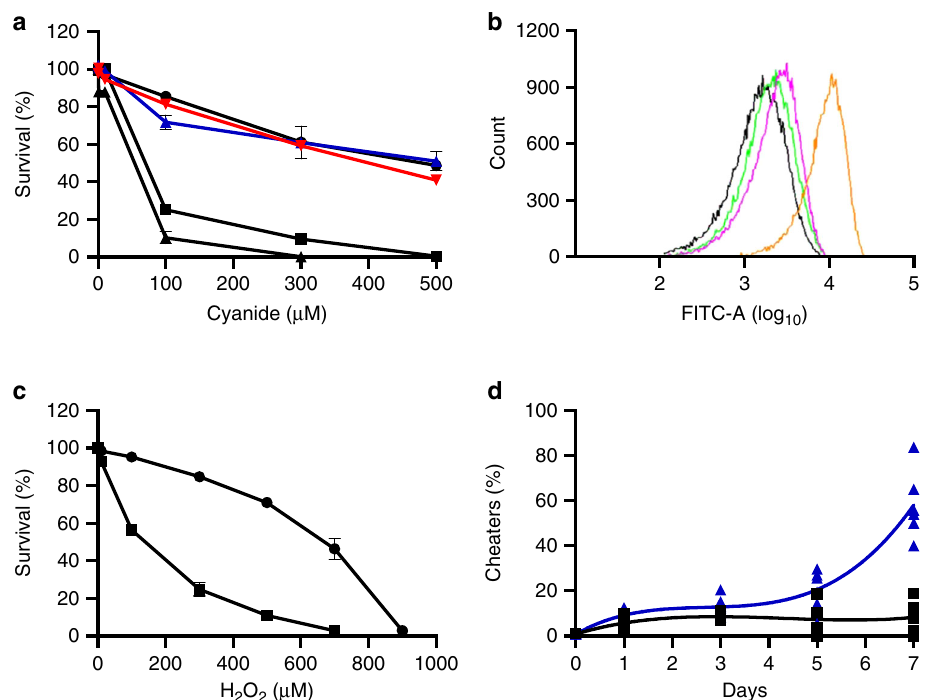
Fig. 1 Wild-type PAO1 is more resistant to cyanide and ROS intoxication than a LasR mutant. a Survival of WT PAO1, LasR-mutant, RhdA-mutant, PA4133- mutant, or CioA-mutant, grown in the presence of different concentrations of cyanide with initial OD 600 of 0.005. The cell density was measured after 16 h of growth. Black circles, WT PAO1; red inverted triangles, RhdA-mutant; blue triangles, PA4133-mutant; black squares, LasR-mutant; black triangles, CioA- mutant. b ROS production from the WT PAO1 and LasR-mutant when grown in LB-MOPS with or without 150 μ M CN − for 40 min. ROS generation was measured by FTC fl uorescence. Black, WT PAO1 without cyanide; green, WT PAO1 with cyanide; pink, LasR-mutant without cyanide; orange, LasR-mutant with cyanide. c Survival of WT PAO1 or LasR-mutants in the presence of hydrogen peroxide after 16 h of growth. Circles, WT PAO1; squares, LasR-mutants. d Cheater frequency in the presence or absence of catalase. The initial frequency of cheaters was 0.01. Black, competition without catalase; blue, competition with 25 U/mL of catalase added daily. All experiments were performed with a minimum of three biological replicates. Lines represent best- fi t polynomial regressions for each condition. For a , c means, s.e.m., and individual biological replicates are shown and in some cases error bars are too small to be